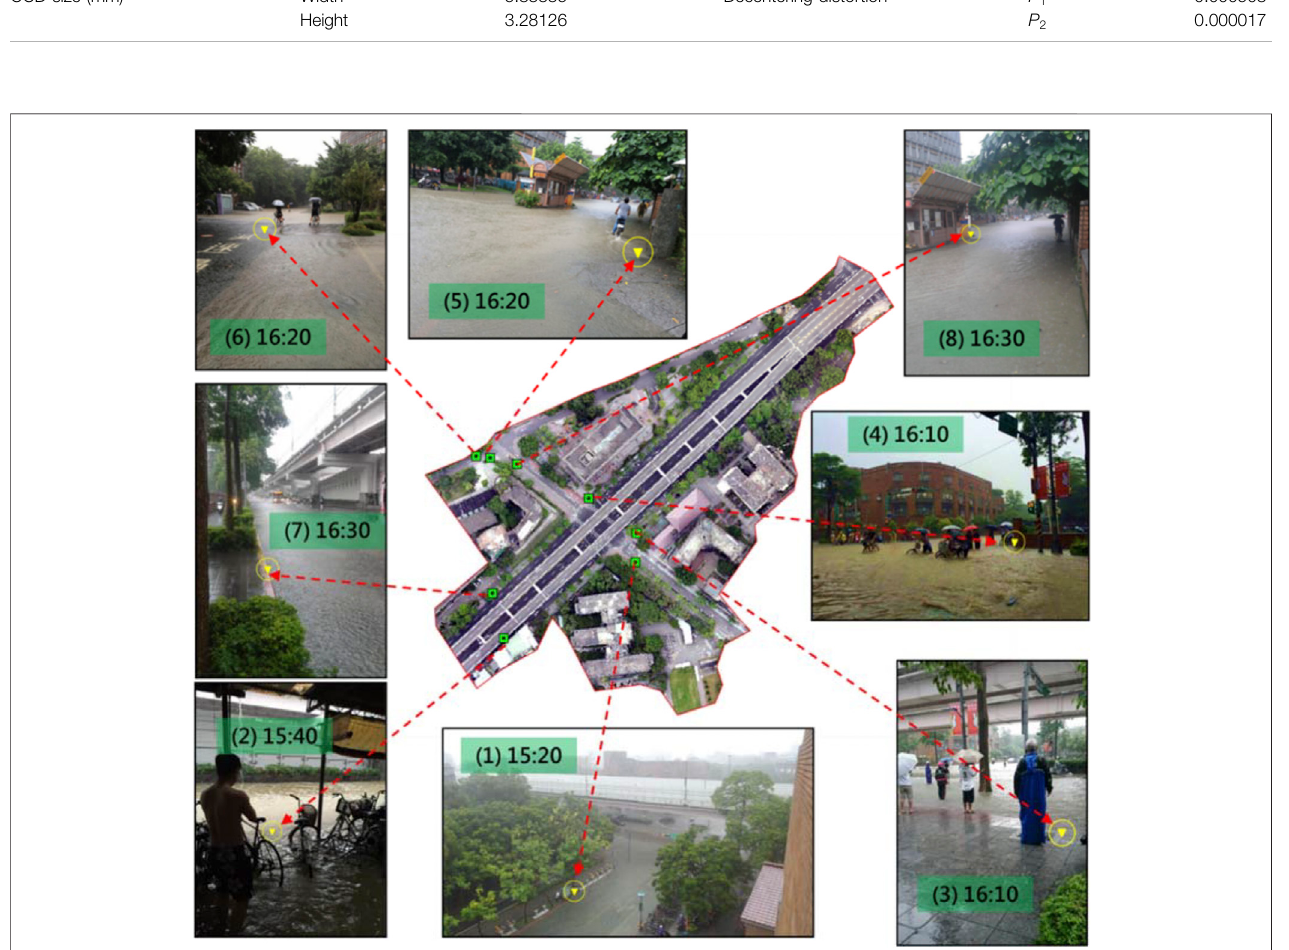
FIGURE 6 | VGI photos from social media and their acquisition time (adopted from PTT, Taiwan).